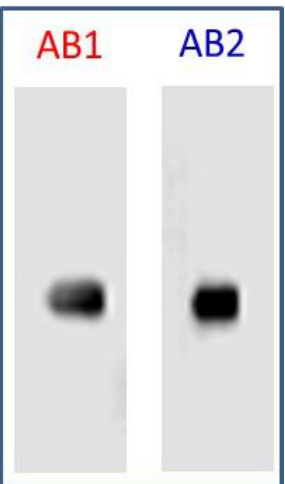
Figure 3. Specificity of capture (AB1) and detection (AB2) antibodies: To validate the utility and specificity of the selected antibodies (AB1 and AB2), LPGDS (20 ng) was resolved on a 12% SDS-PAGE, blotted to PVDF membrane, blocked with 3% milk in TBS and probed with AB1 and AB2 culture supernatants. Secondary antibody is HRP labeled goat anti mouse from Jackson Laboratories (1:5000) and HRP labeled goat anti rabbit from Biorad (1:300). Protein bands were detected by ECL (GE Healthcare) with a LICOR C-digit reader (scan time 6